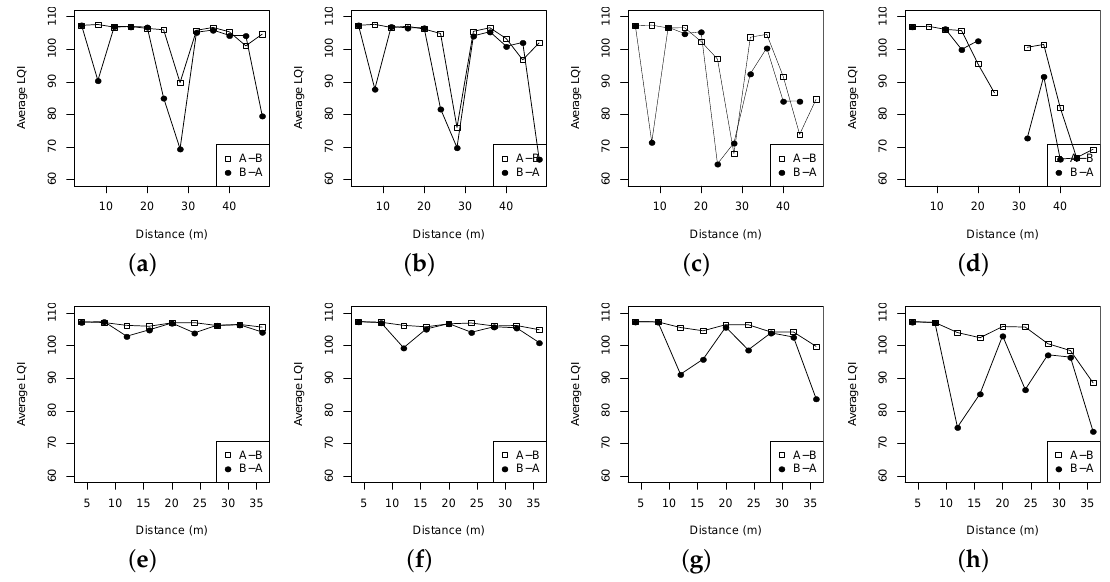
Figure 3. Link-quality indicator (LQI) distributions vs. distances with different transmit powers under two different forests. ( a ) Bajia, tx = 31; ( b ) Bajia, tx = 27; ( c ) Bajia, tx = 19; ( d ) Bajia, tx = 15; ( e ) Campus, tx = 31; ( f ) Campus, tx = 27; ( g ) Campus, tx = 19; ( h ) Campus, tx =